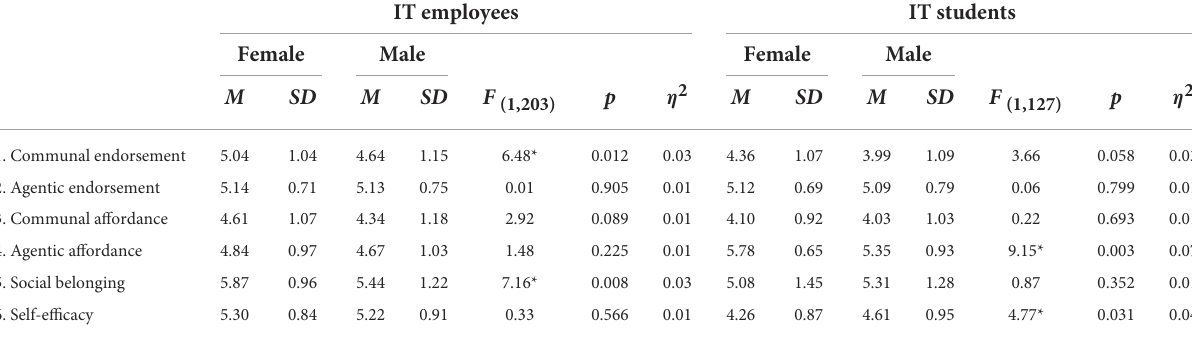
TABLE 1 Results of a series of MANOVAs showing differences between male vs. female employees and male vs. female students in the IT